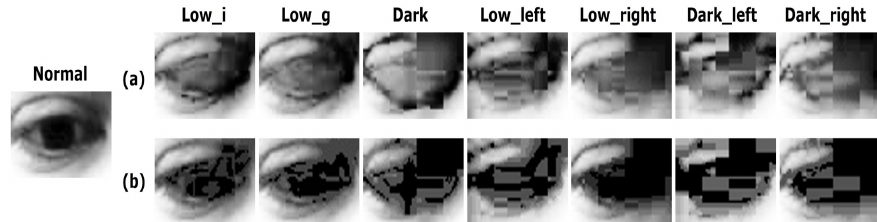
Figure 11. Comparison of binary images of the eye: ( a ) Images enhanced by EnlightenGAN. ( b ) Original low and dark illuminated